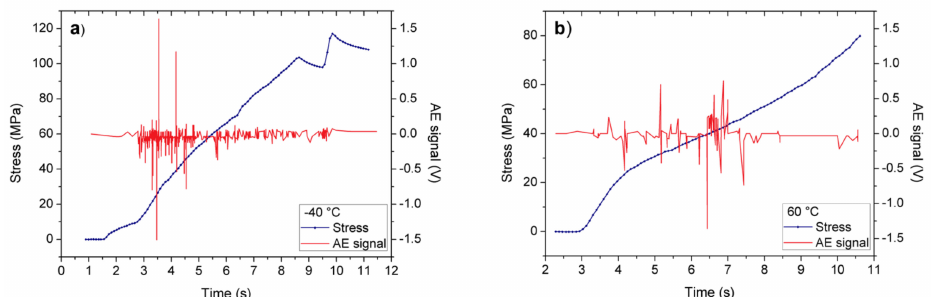
Figure 2. Stress-strain curve (blue curves: the strain is proportional to the time) and the acoustic emission events (voltage of the piezoelectric sensors), detected simultaneously in polycrystalline Sn samples ( a ) at − 40 ◦ C and ( b ) at 60 ◦ C.